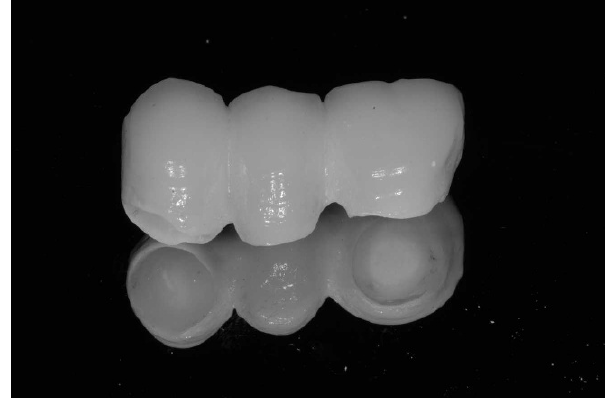
Figure 1 - Three-unit, all-ceramic prostheses for 14-16 rehabilita- tion crowns for implants. The zirconia core was surrounded by feldspathic